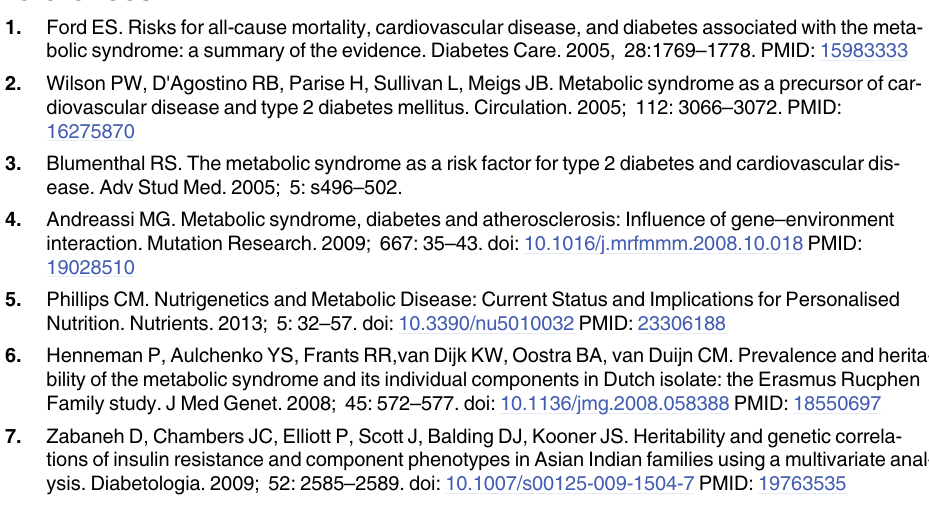
S1 Table. AICs for the full and nested models for Danish and Chinese twins. The table pres- ents AICs for all models fitted (both full and nested models) with the AICs for the best fitting models marked as